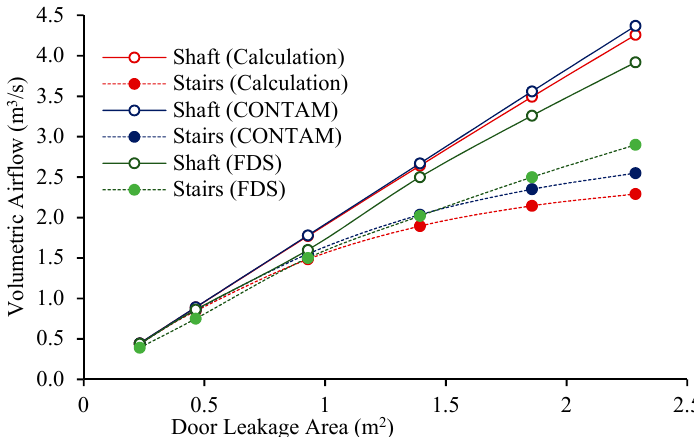
Figure 6. Effect of stairwell friction on airflow at the 1st floor, for a 10-storey shaft with equally distributed openings.